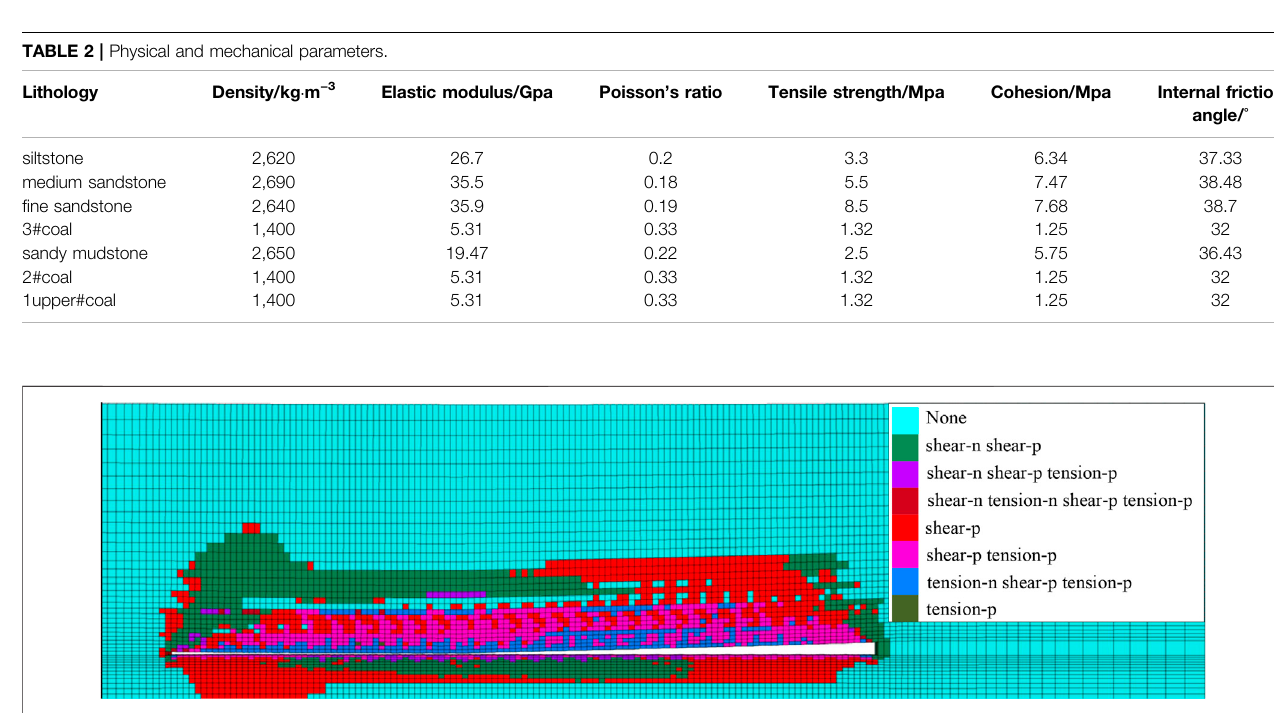
FIGURE 10 | Evolutionary laws of plastic zones during thickening coal seam mining.